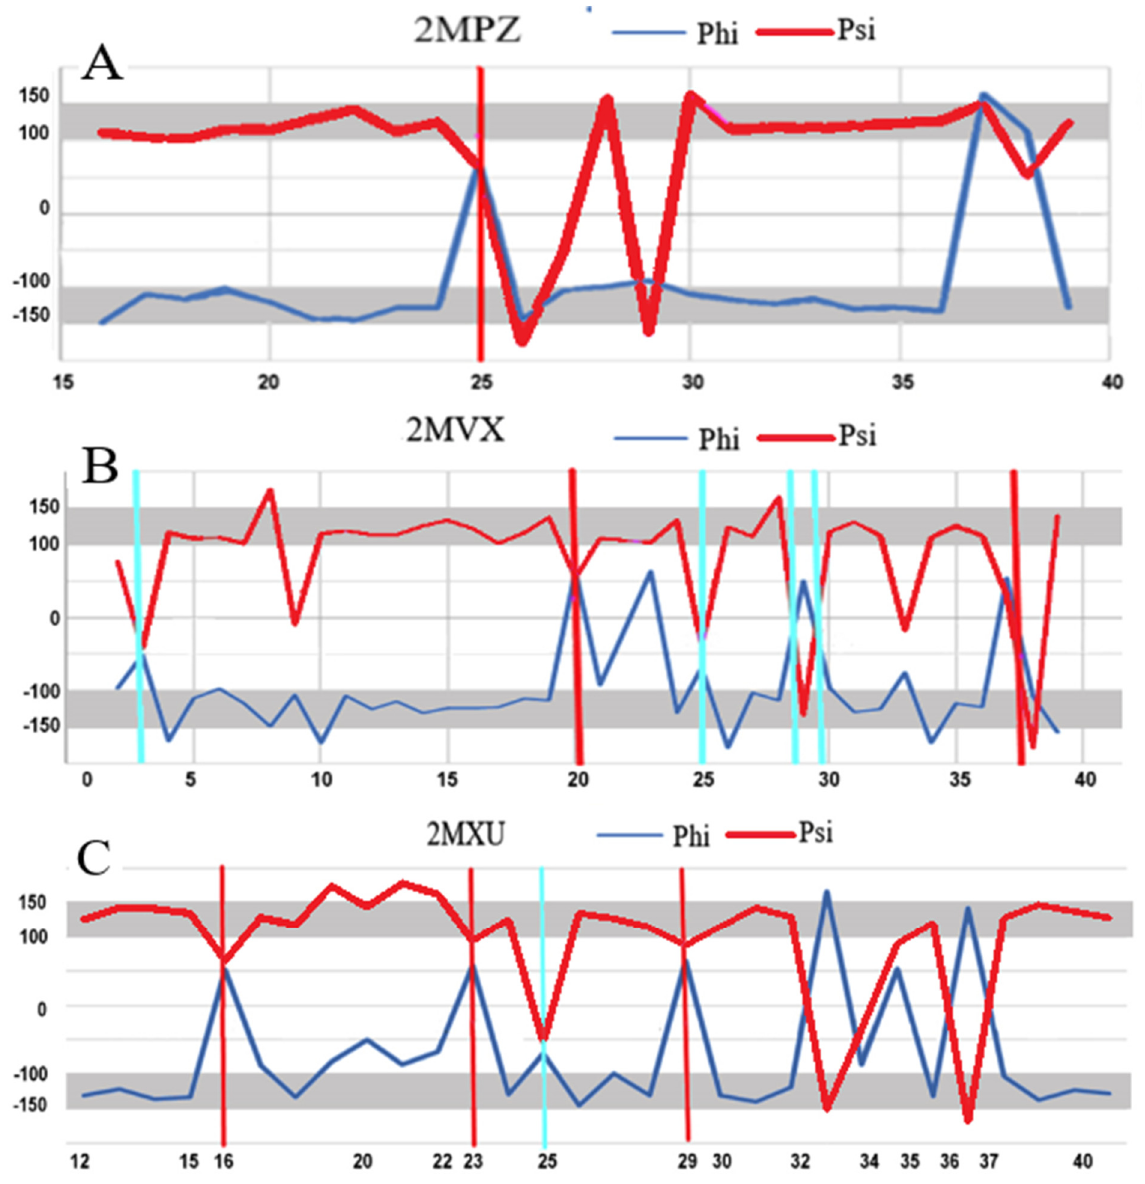
Figure 4. Comparisons of Phi and Psi angle profiles in the ABeta amyloids: ( A )—2MPZ; ( B )—2MVX; ( C )—2MXU. Gray area in ( A )—highlighting areas for Phi and Psi with the relation Psi = − Phi. Vertical red lines—amino acid positions with L α helical conformation; cyan—R α helical.